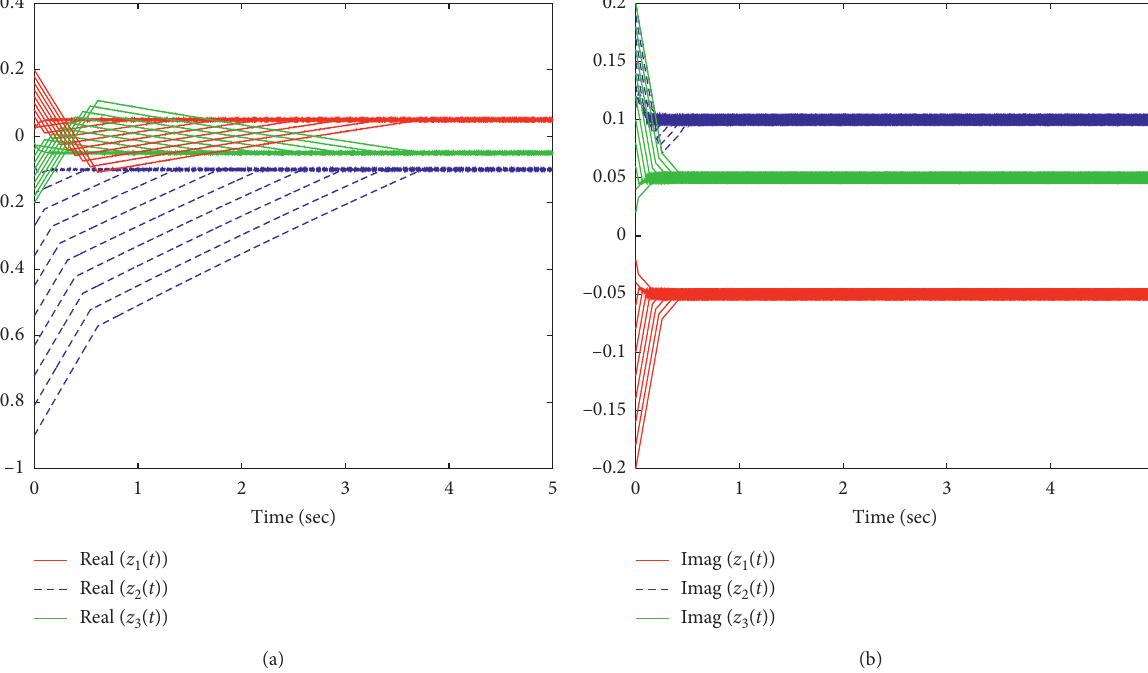
Figure 3: The state variables ω ( t ) with ten arbitrary initial states for Example